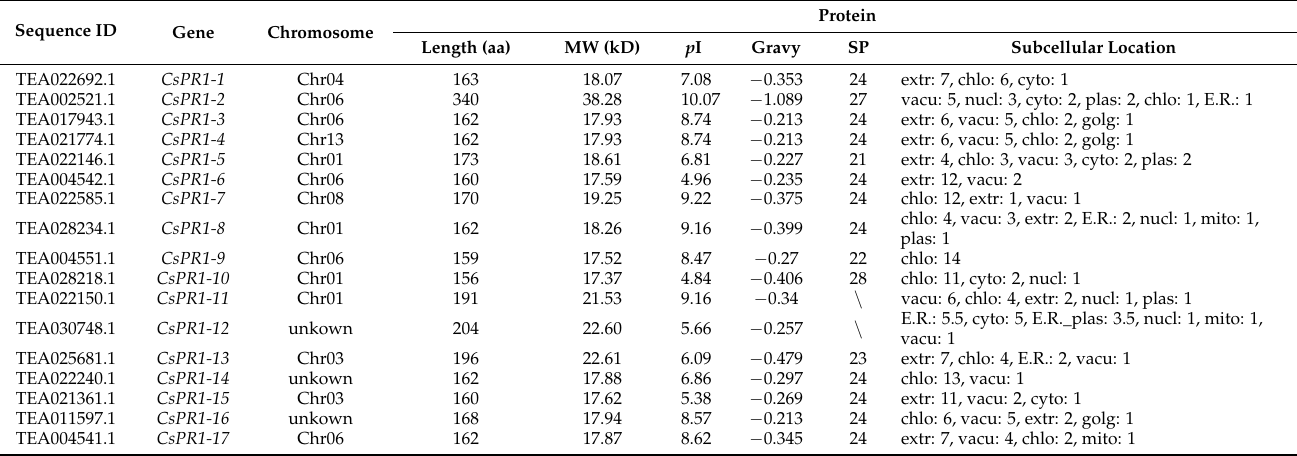
Table 1. Identified PR1 genes in the genome of the tea